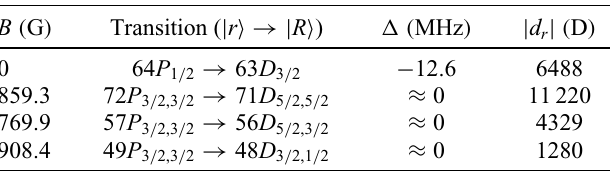
TABLE I. List of possible Cs Rydberg states to use for a near- resonant interaction with the NaCs N = 0 to N = 1 rotational transition at zero magnetic field and various magnetic fields near the NaCs Feshbach resonance at 865 G. The notation used for , where the m J are particularly relevant the atomic states is nL j , m J for states at high magnetic field. For the high field states, three different polarization options are listed. Dipole moments are cal- culated with the Alkali Rydberg Calculator [44], and energy spacings include the quadratic Zeeman shift, which is detailed in Appendix